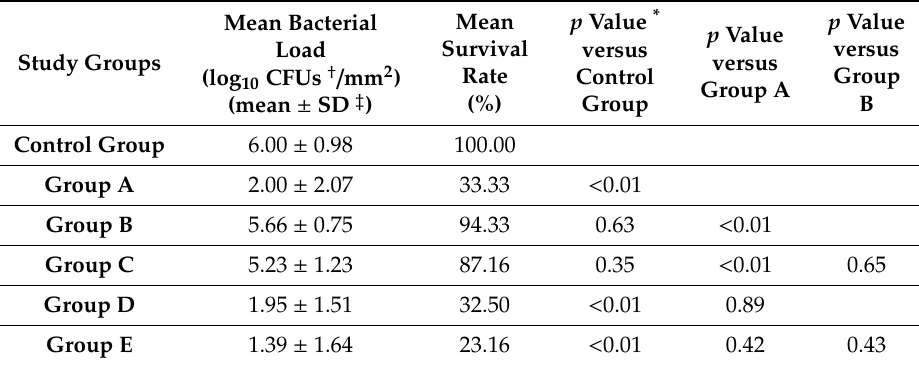
Table 2. Enterococcus faecalis CCM2541 counts in control and experimental